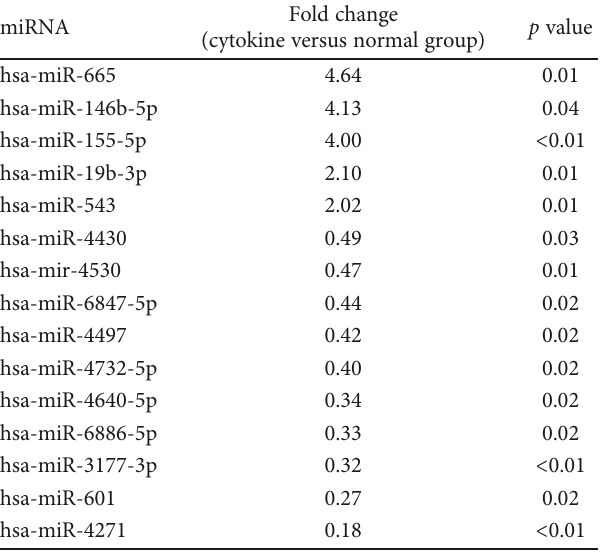
Table 1: miRNAs that were di ff erentially expressed between the cytokine and normal groups.